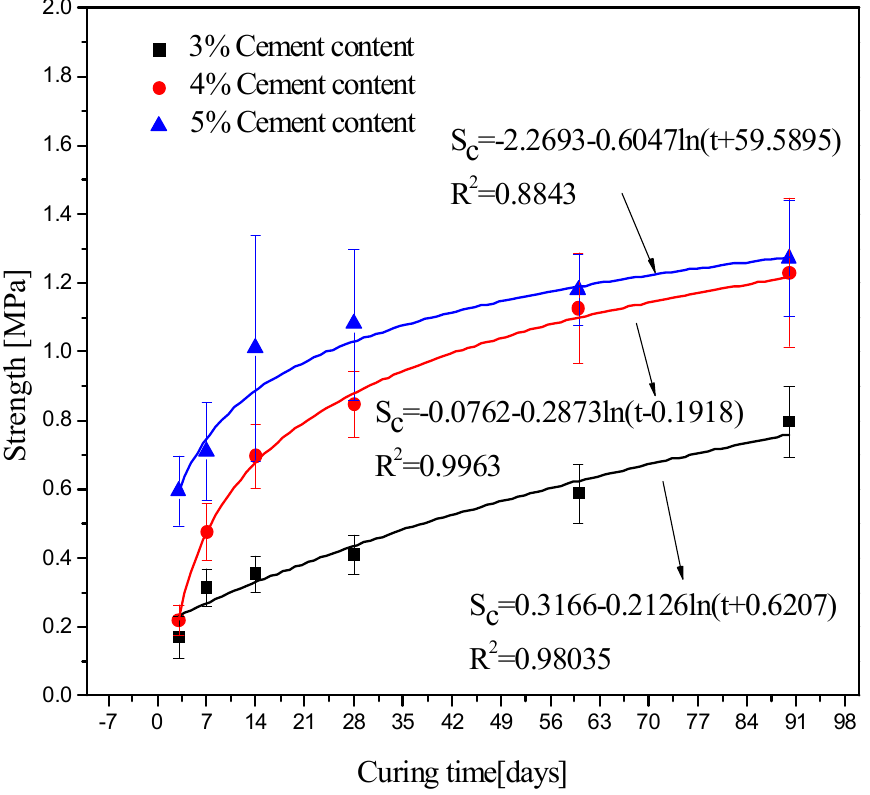
Figure 4. Variation patterns of flexural tensile strength with curing time and cement content.